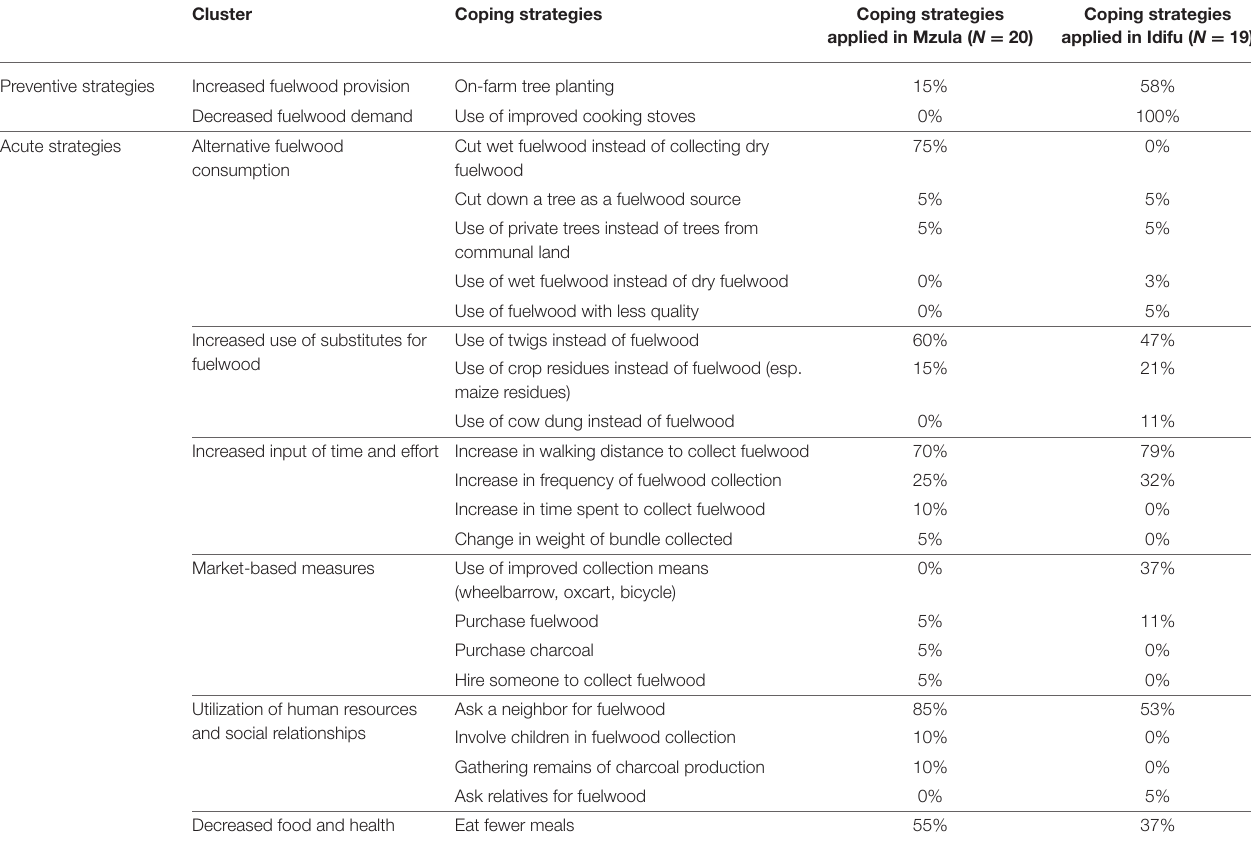
TABLE 1 | Coping strategies derived from the household interviews of both case study villages including a quantified